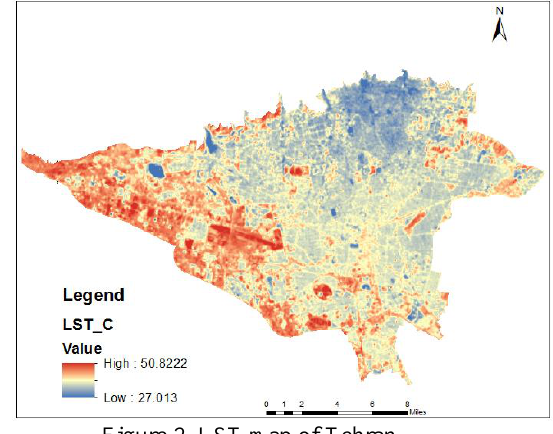
Figure 2. LST map of